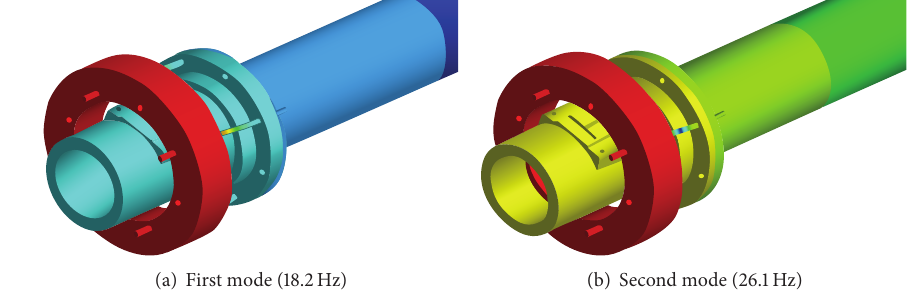
Figure 8: Lowest two mode shapes of a beam with TMD.